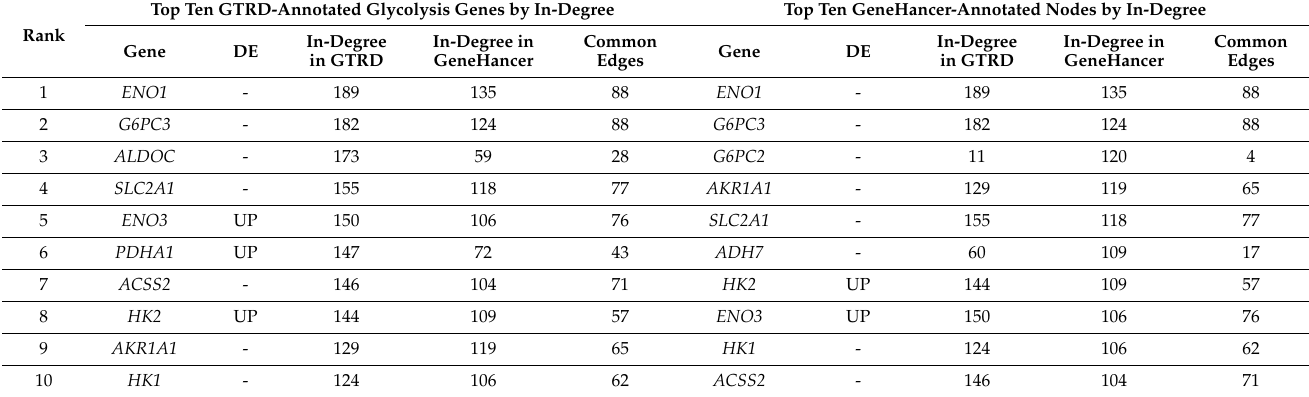
Table 19. Top ten target genes in GTRD- and GeneHancer-annotated transcription factor–target gene network of untreated RA CD8 + Tem cells.